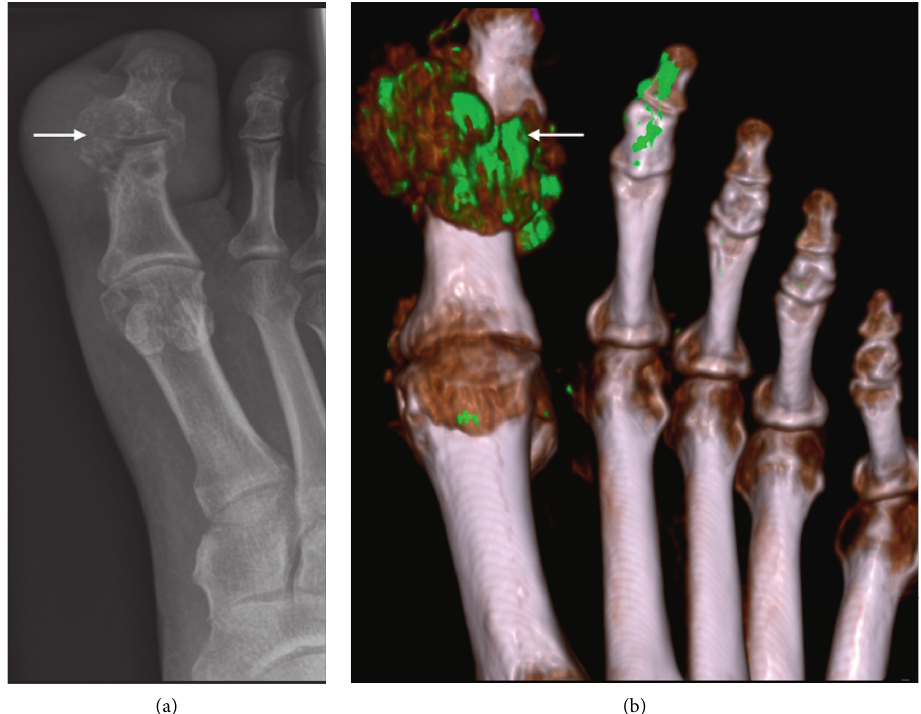
Figure 23: Gouty tophus in a 39-year-old man presenting with a swollen and erythematous toe which was clinically suspected to be an infection. X-ray showed 1 st MTPJ erosion at the medial border associated with dense soft tissue swelling (arrow). Dual-energy CT with material decomposition helped differentiate urate crystals (mapped as green, arrowed) from calcium (blue, not present in this